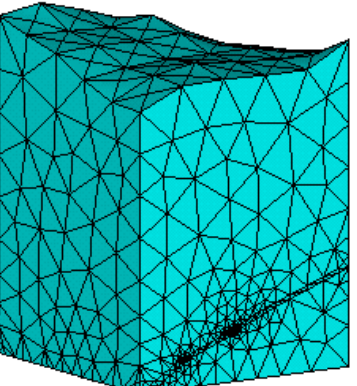
Figure 6. Finite element model meshing.